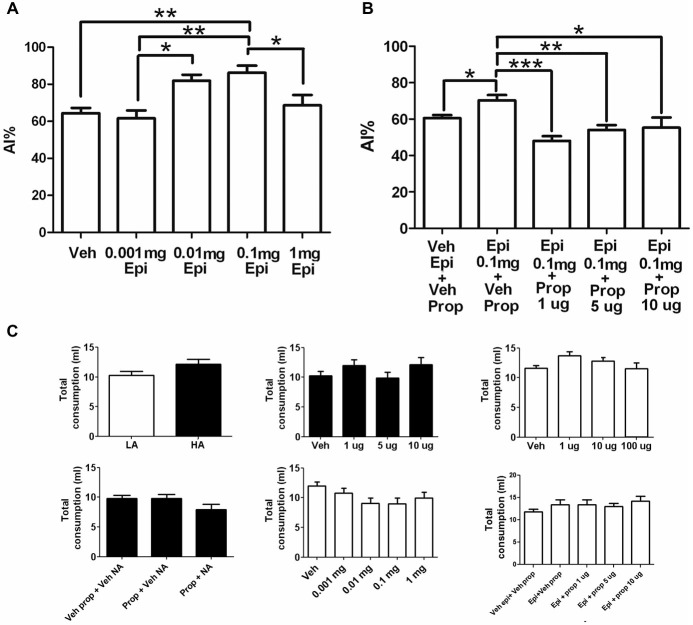
Effects of systemic epinephrine in neophobia and its modulation by the insular cortex. (A) Dose response curve of systemic epinephrine in a LA context. Note that 0.1 mg of epinephrine induced a significant increase in taste neophobia (N = 9, 10, 9, 10, 10; ***p < 0.001) when the novel taste was presented in a LA context. (B) Dose response of intra-insular propranolol after a systemic epinephrine when novel taste is presented in a LA context. Note that 1μg of intra-insular propranolol (Epi + Prop 1μg) blocked the increase in neophobia induced by 0.1 mg of systemic epinephrine (Epi + Veh Prop; (N = 8, 7, 8, 7; **p < 0.01). (C) Injections did not induce significant changes in total liquid consumption. Experiments in LA are shown in open bars, experiments performed in HA are shown in closed bars. Upper-middle: propranolol; left-upper right; noradrenaline; center-bottom: epinephrine. *p < 0.05; **p < 0.01; ***p < 0.001.